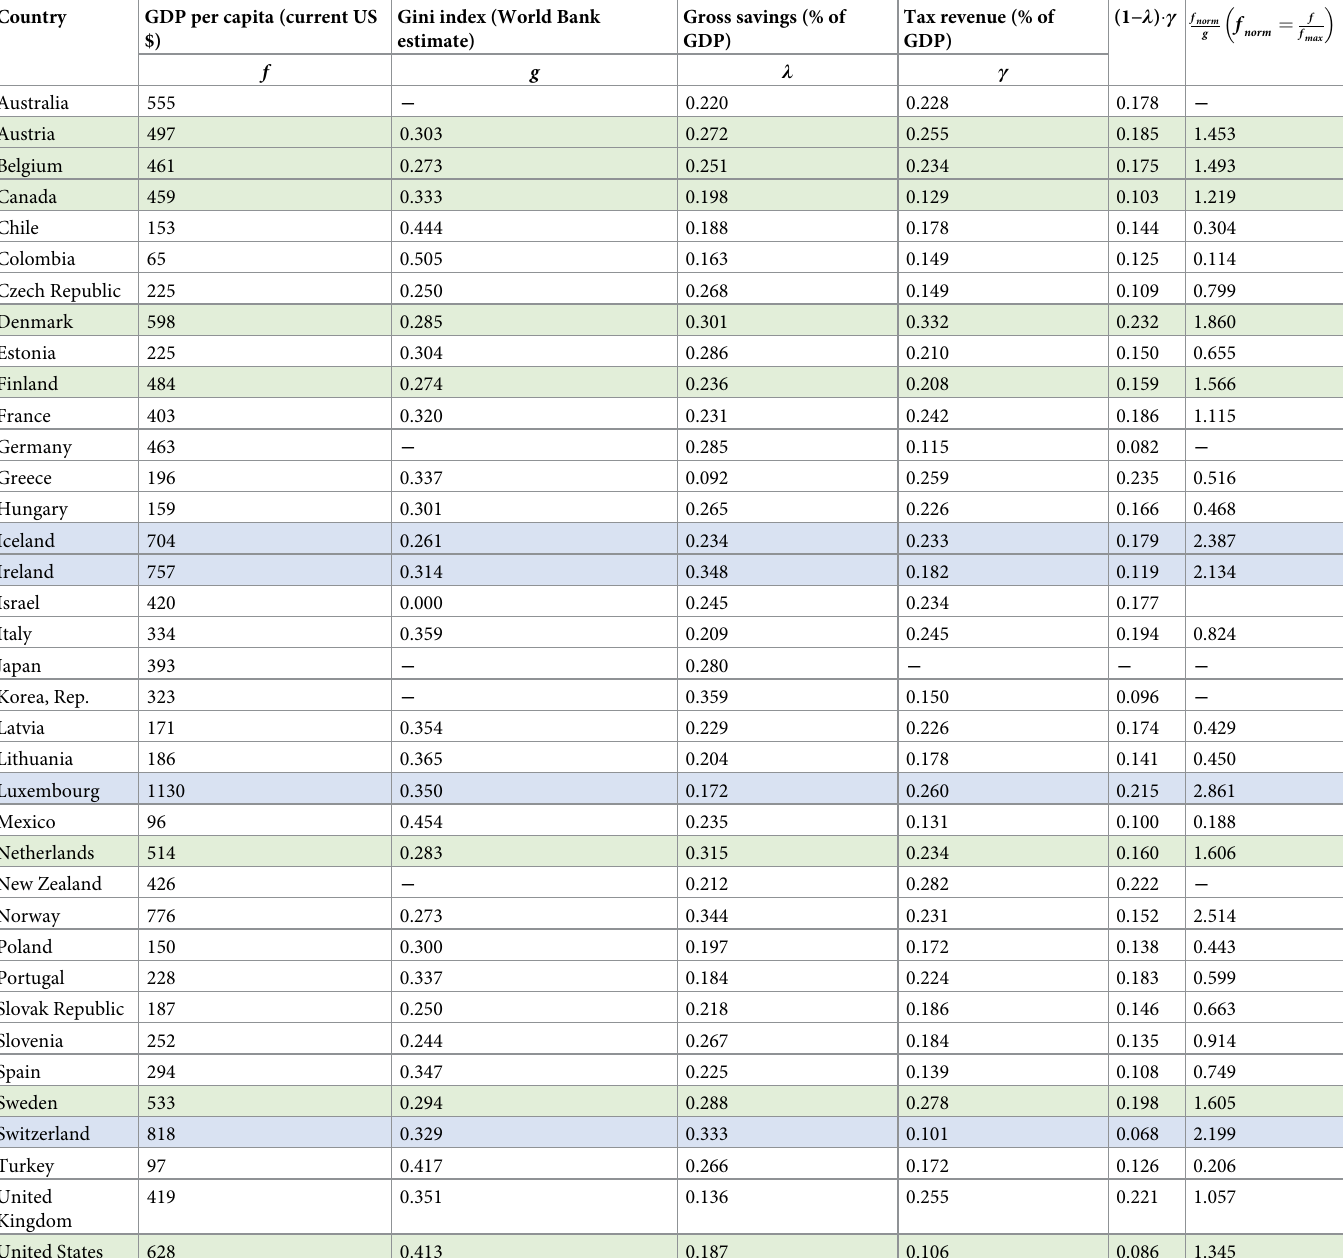
Table 1. Data of Organisation for Economic Co-operation and Development member countries.